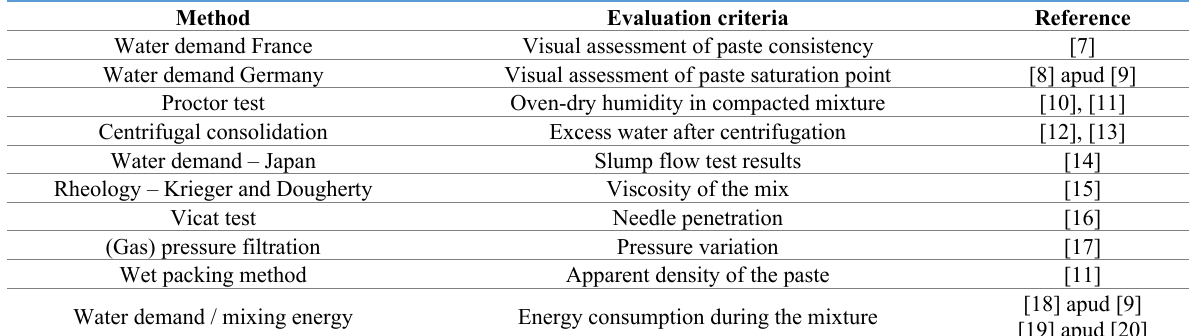
Table 1. Packing density methods available for Portland cement and fine